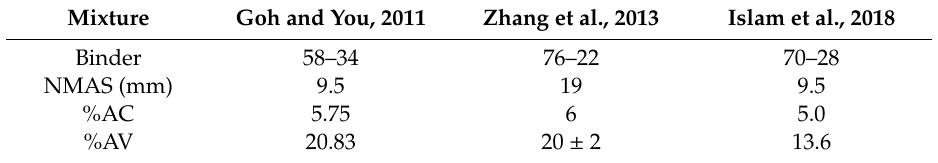
Figure 4. Dynamic Modulus master curves of unconditioned specimens in: ( a ) semi-log scale; ( b ) log-log scale. Table 3. Properties of PA (after Goh and You, 2011, Zhang et al., 2013 and Islam et al., 2018 [16–18] ).